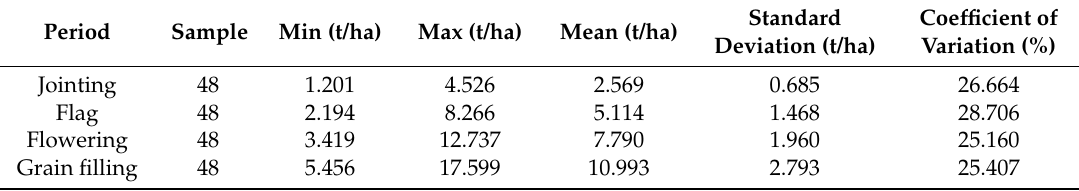
Table 1. Statistics of AGB measurement in study area.